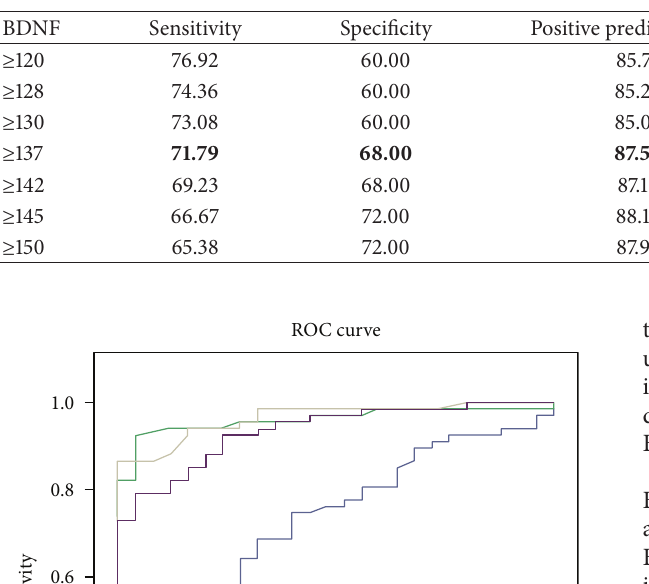
Table 4: Diagnostic screening tests results for BDNF.